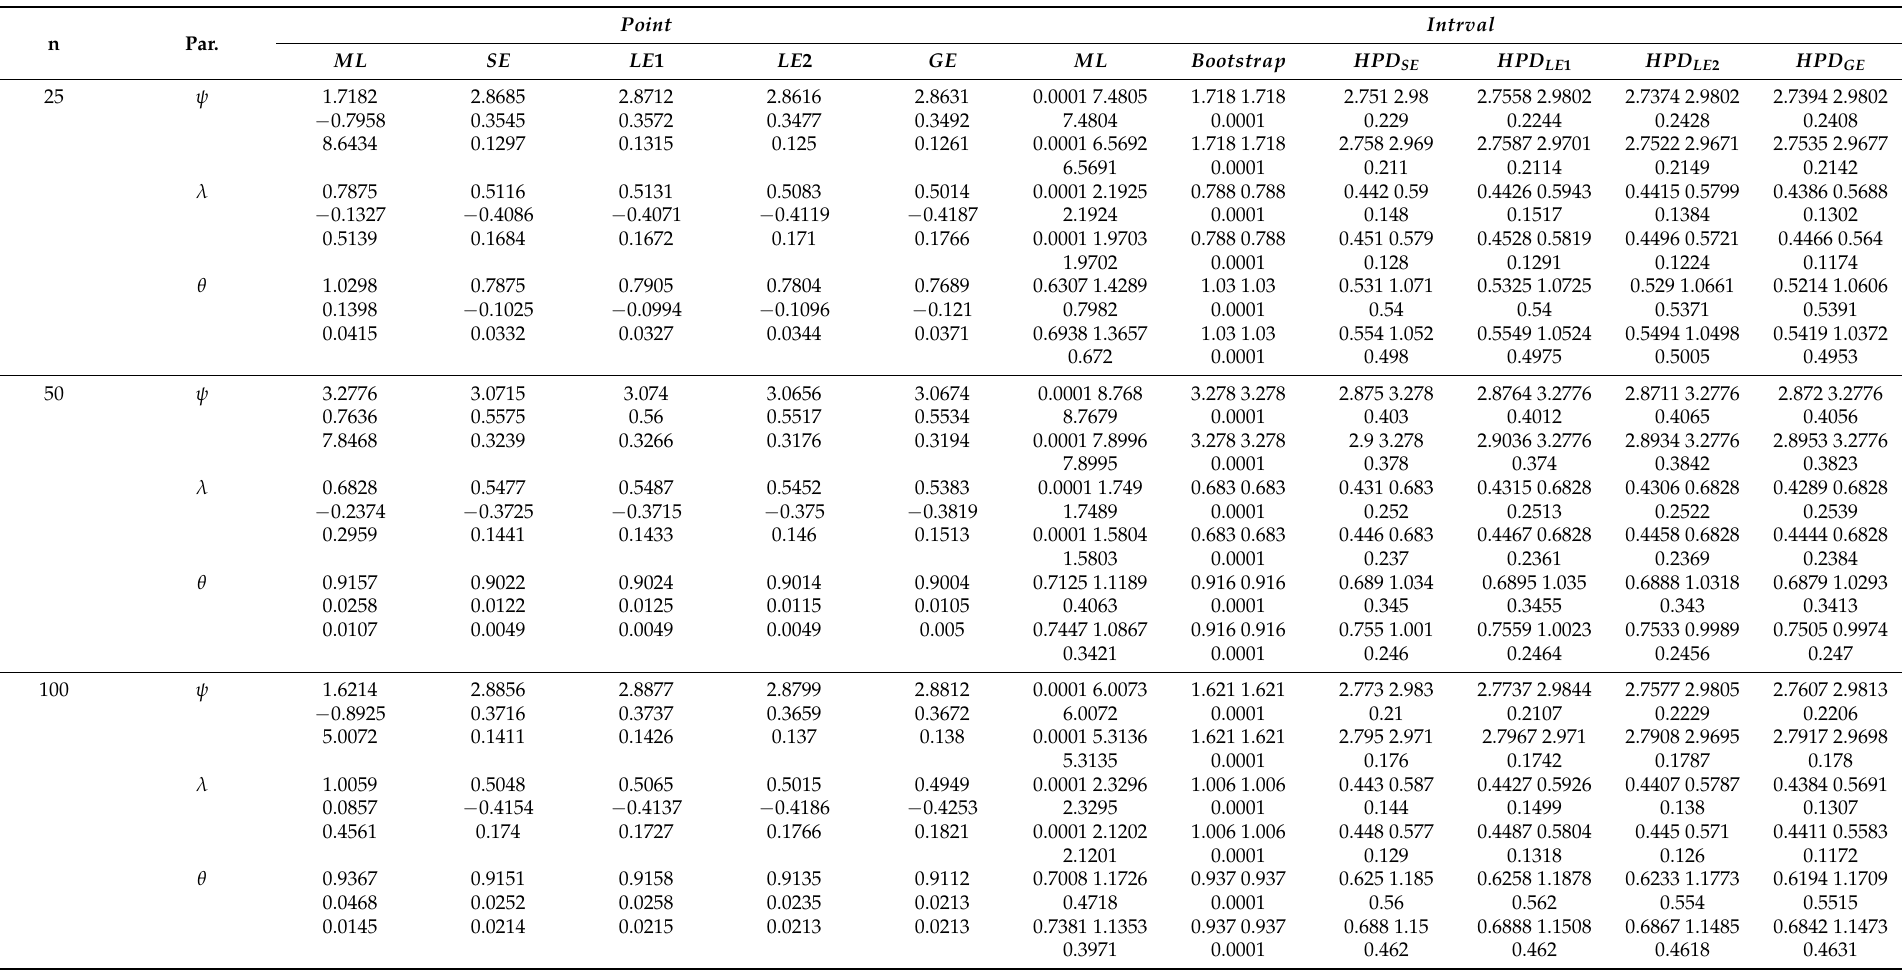
Point estimate: first, second, and third lines represent estimate, baises and ER, respectively. Interval estimate: 95% and 90% interval estimate, respectively. The first and second lines show the credible HPD interval and the corresponding width of the parameter,